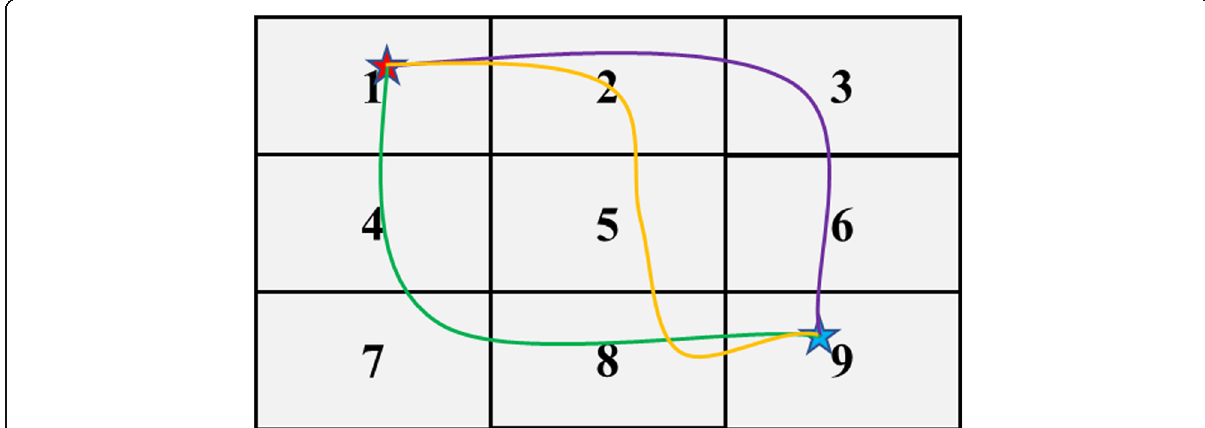
Fig. 1 Schematic diagram of upper-level path